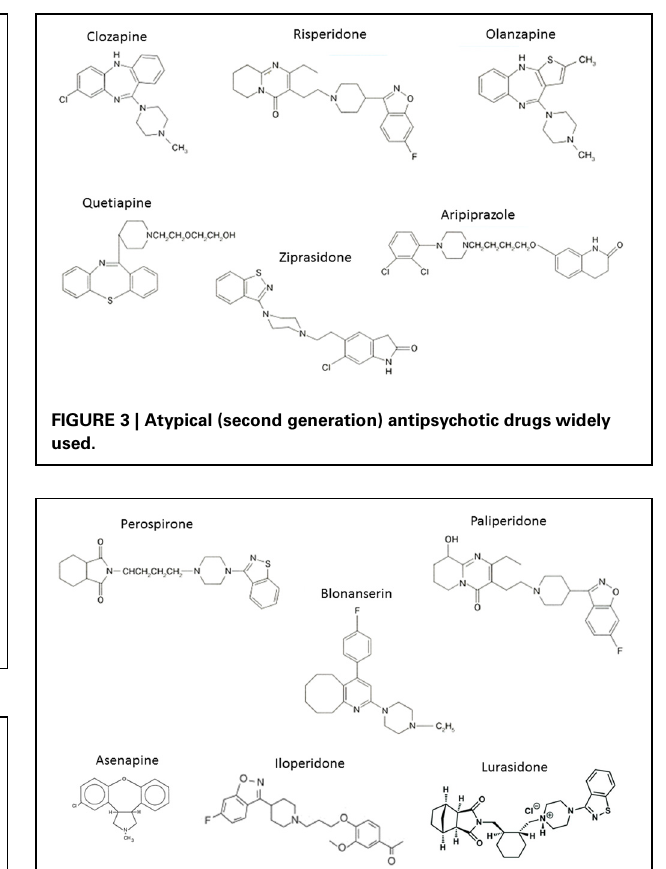
FIGURE 4 | Atypical (second generation) antipsychotic drugs recently